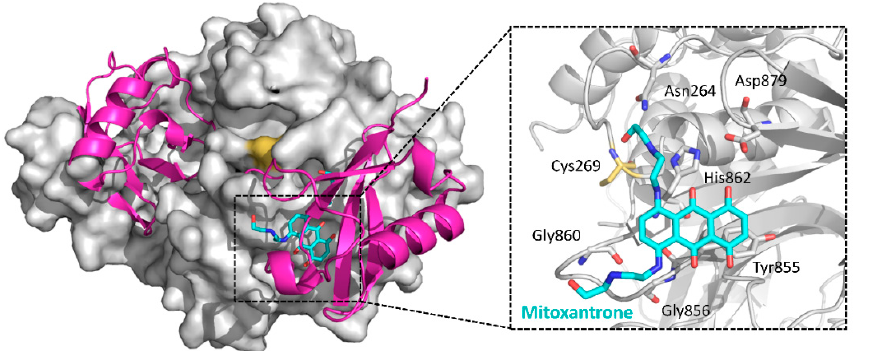
Figure 21. Crystal structure of the USP15-mitoxantrone complex and a close-up of the binding site (PDB ID: 6GH9). A di-ubiquitin molecule is modeled into the complex based on a superposition with a USP30 C77A Lys 6 -linked di-ubiquitin structure (PDB ID: 5OHP), the closest available USP structure in complex with a substrate. Ubiquitin: magenta; USP15 catalytic domain: gray; mitoxantrone: cyan sticks. In the close-up figure, key residues involved in binding and the catalytic triad (Cys269-His862-Asp879) are shown as sticks, with Cys269 marked orange, and the di-ubiquitin molecule is omitted for clarity.